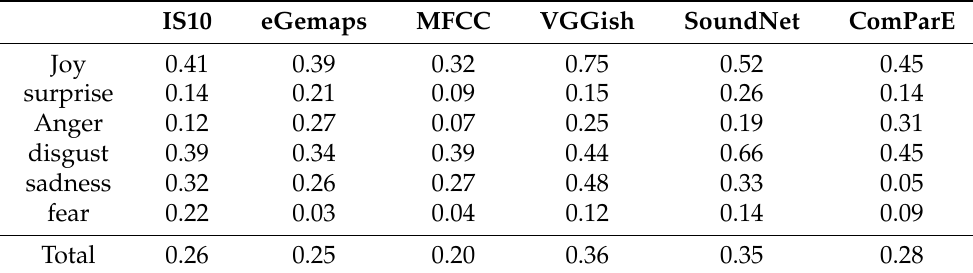
Table 4. Per-Class Emotions accuracy of multiple features on BAUM-1s dataset.